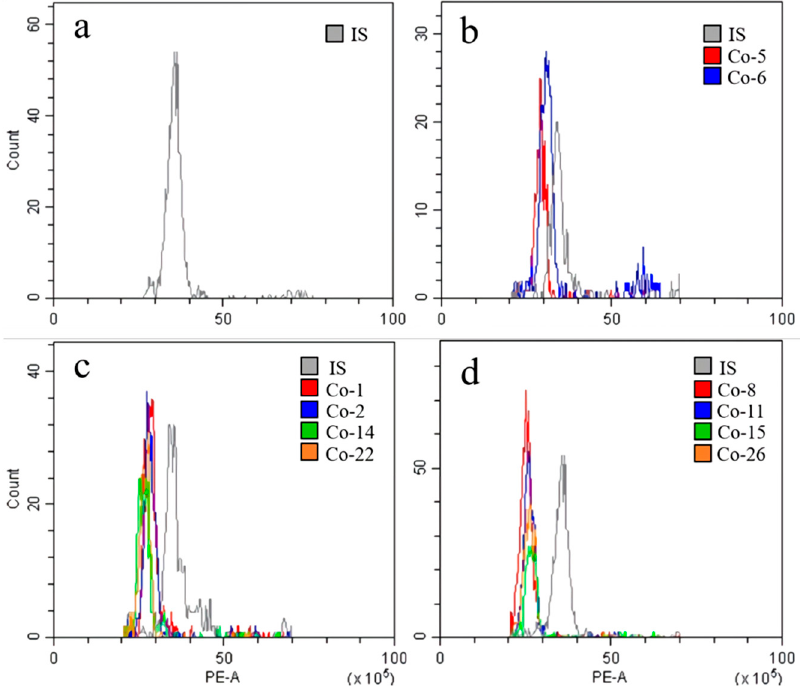
Figure 3. Analysis of 2C DNA content in different clones of Cnidium officinale plants using flow cytometry: histograms showing the DNA content of Nicotiana tabacum cv. xanthi for internal standard (IS) ( a ); clones with high DNA content (HD) ( b ); clones with moderate DNA content (MD) ( c ); and clones with low DNA content (LD) ( d ). Table 1. DNA content of ten in vitro-grown clones of Cnidium officinale .